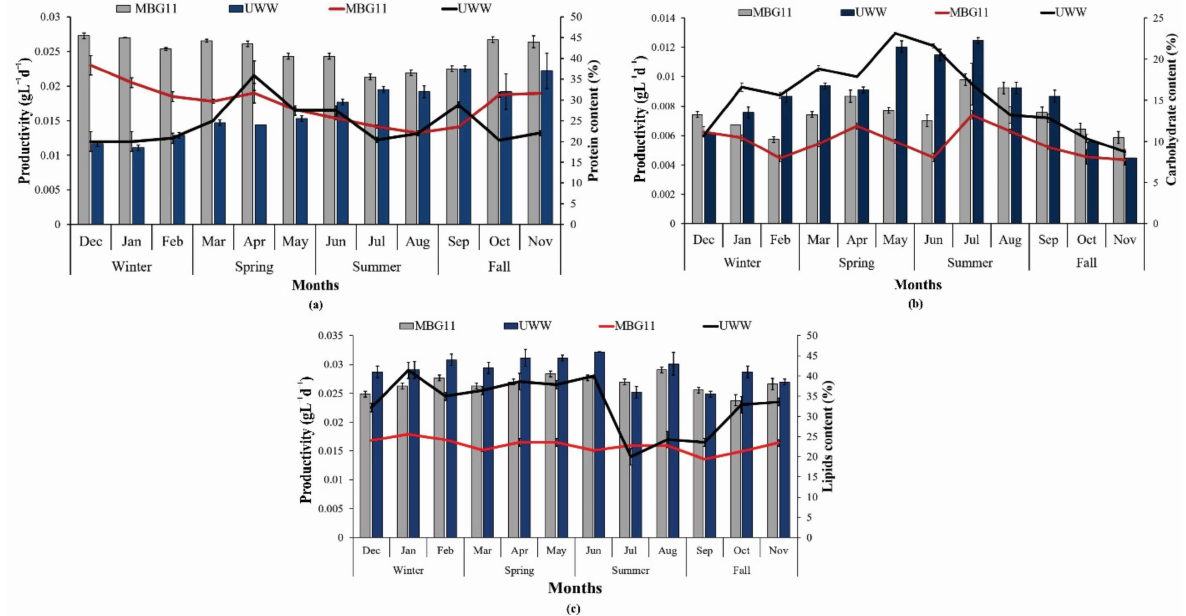
Figure 2. Production and variations in metabolite composition: ( a ) protein content (%) and produc- tivity (gL − 1 d − 1 ) in response to nutrient variation in wastewater; ( b ) carbohydrate content (%) and productivity (gL − 1 d − 1 ) in response to nutrient variation in wastewater; ( c ) lipid content (%) and productivity (gL − 1 d − 1 ) in response to nutrient variation in wastewater. The bars show content (%) while line curves show the productivity (gL − 1 d − 1 ) of